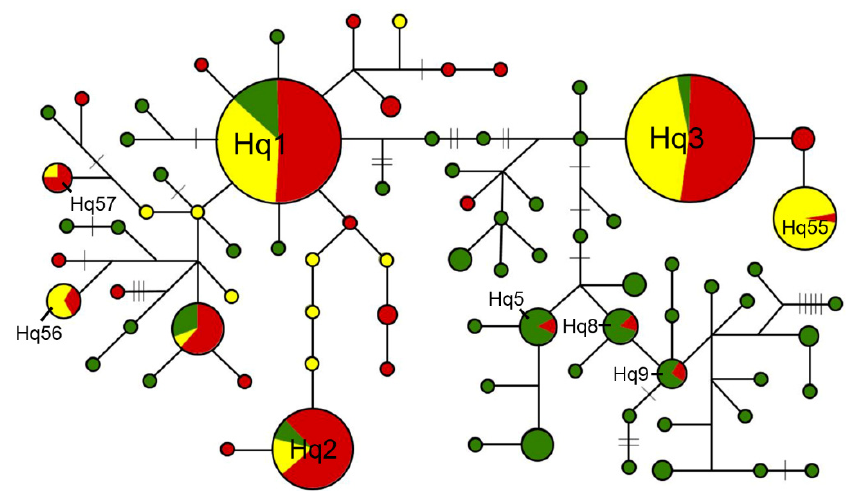
Figure 6. Haplotype networks constructed based on the DNA sequence polymorphisms of the qsh1 gene. The network shows WD samples clustered into a few major groups with a few key haplotypes shared by WD (red), CV (yellow), and W (green) rice samples. Only a few WD haplotypes are nested among the W haplotypes. The size of the circles indicates the relative number of samples in the haplotypes. Lines between circles represent one-step variation. Dashes on the lines represent more than one step of variation/mutation.